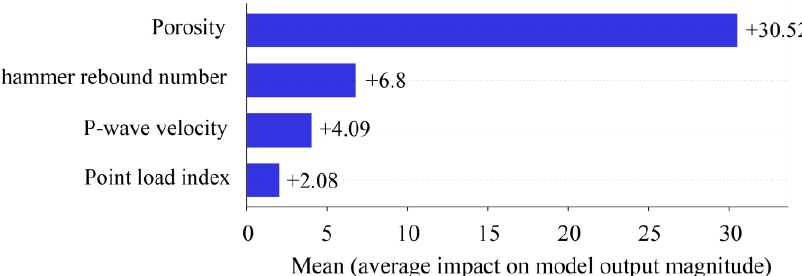
Figure 13. Parameter importance results based on the PRO-RF model.